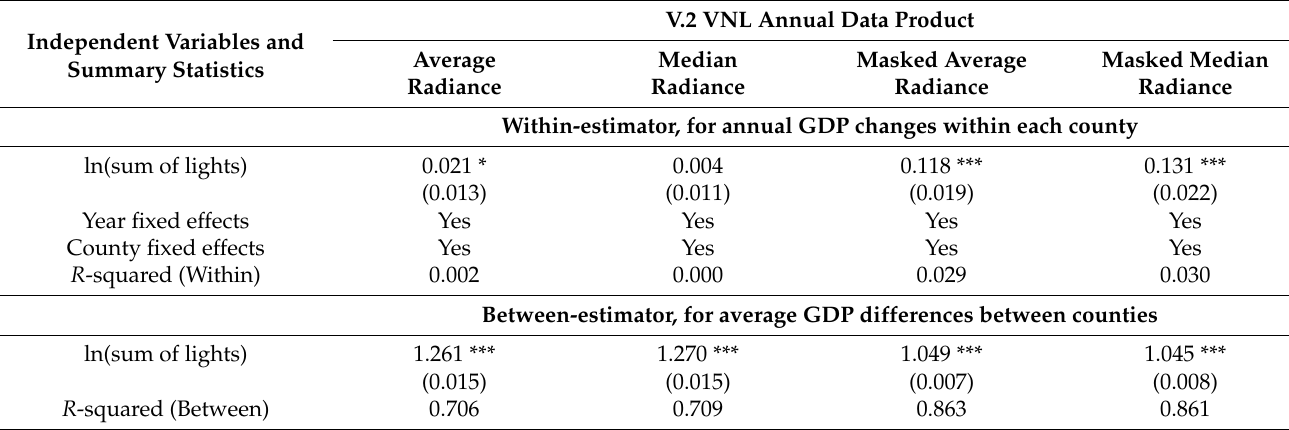
Table 2. Relationships between VIIRS V.2 NTL and county GDP: within and between estimator results. Independent Variables and Summary